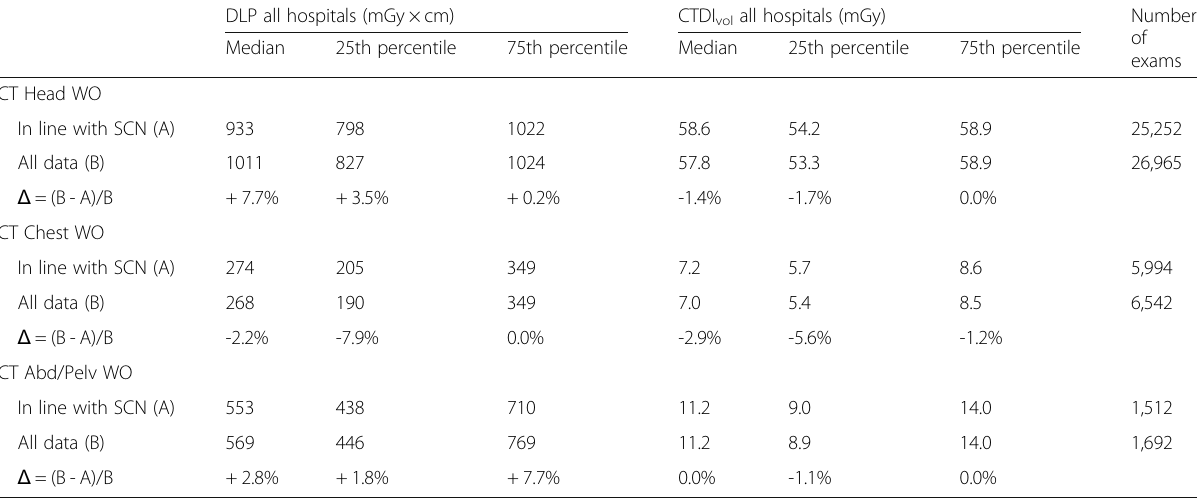
Table 5 Dose-length product (DLP) and volumetric computed tomography dose index (CTDI vol ) for “ CT Head WO ” , “ CT Chest WO ” and “ CT Abd/Pelv WO ” : data for exams in line with the study common name and for all exams DLP all hospitals (mGy ×